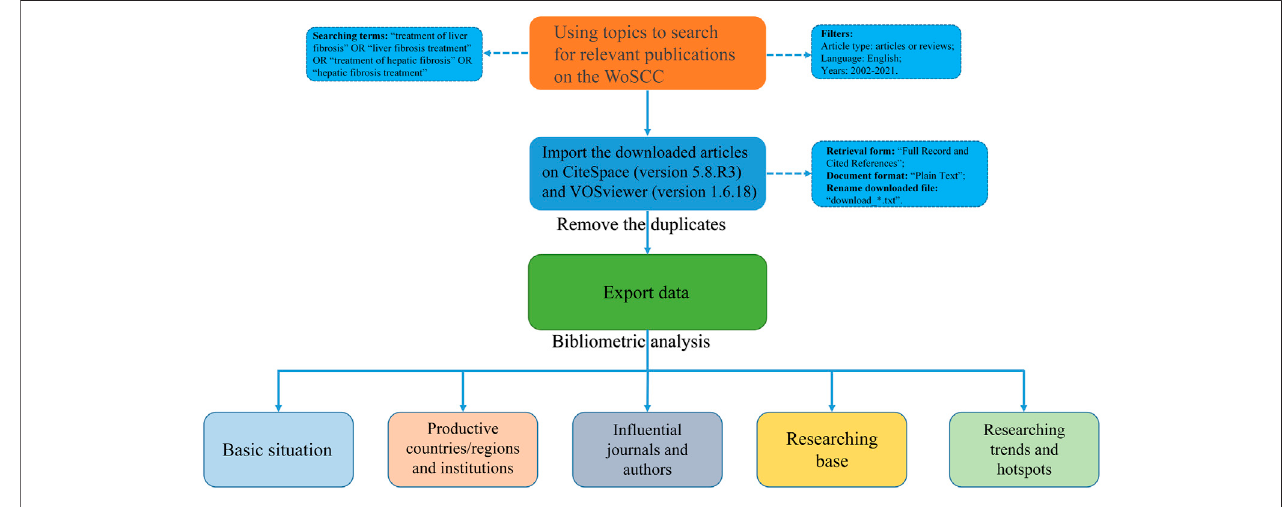
FIGURE 1 | Flowchart of this study.jpg.